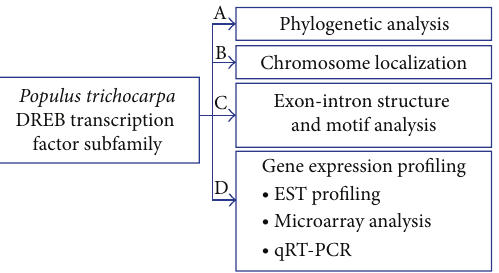
Figure 1: Integrated systems analysis workflow for elucidation of the role of DREB subfamily in the bioinformatics and data analysis in Populus . A: A phylogenetic analysis was performed using all the DREB subfamily amino acid sequences from Arabidopsis and Popu- lus by MEGA 4 software. B: Each of the DREB genes’ chromosomal position in Populus was using the Phytozome and Joint Genome Institute websites. C: The exon/intron organization for individual DREB genes was using the gene structure display server (GSDS) program and motif analysis was performed using the program MEME (v4.3.0). D: Gene expression profiling of Populus